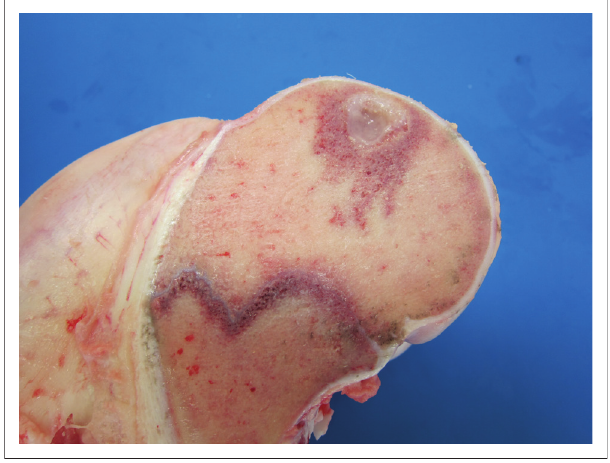
Source : Photo taken by Leon Prozesky FIGURE 3: Subchondral cysts containing necrotic material and surrounded by well-vascularised fibrous connective tissue.